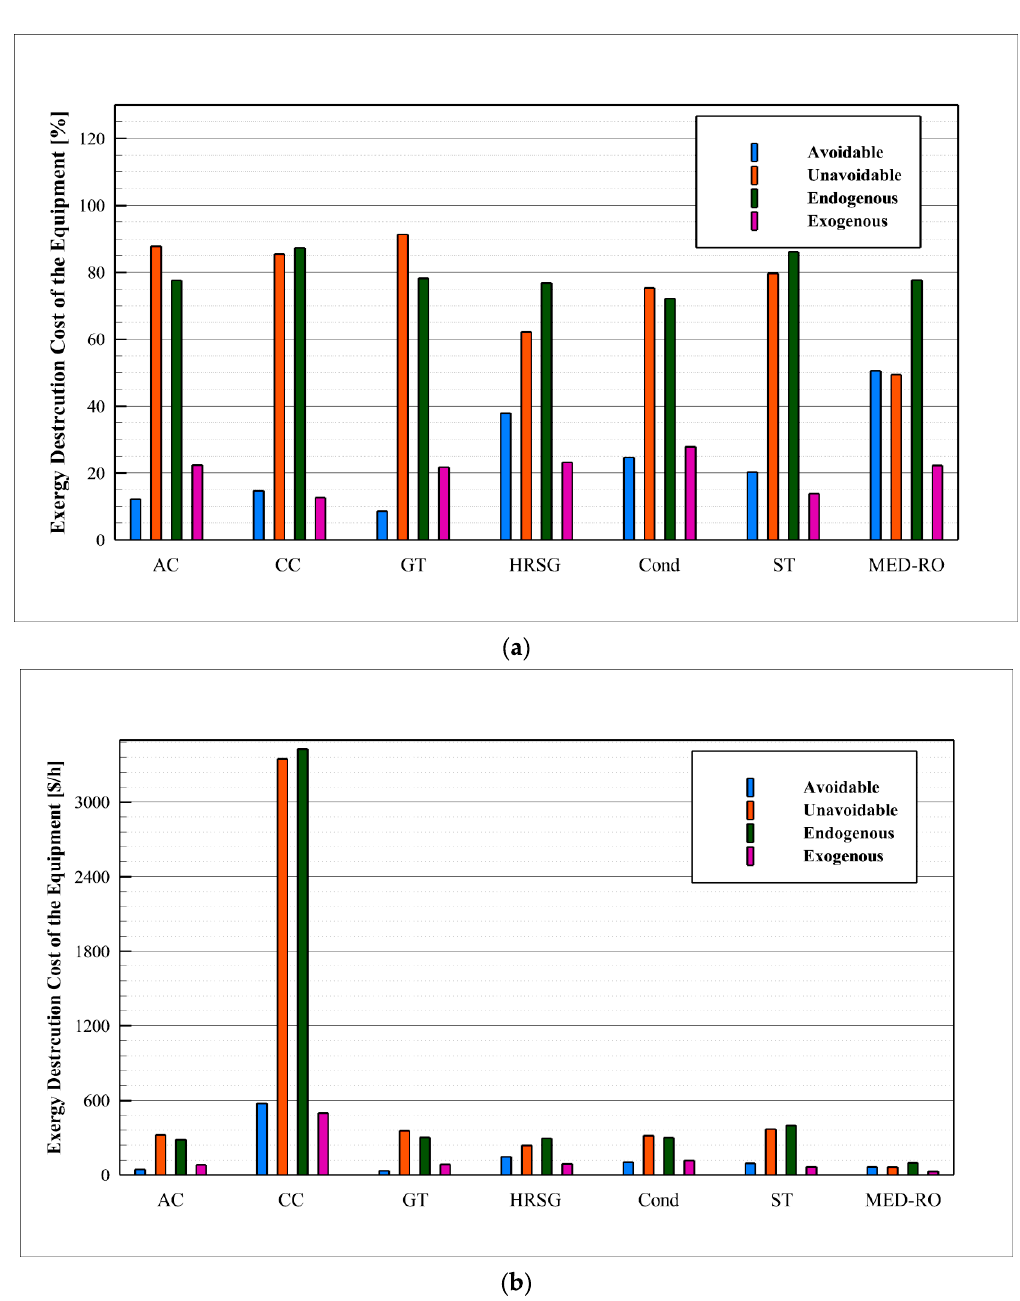
Figure 7. Distributions of avoidable/unavoidable and endogenous/exogenous exergy destruction cost for different system components in ( a ) relative values and ( b ) quantitative values. AC, air compressor; CC, combustion chamber; GT, gas turbine; HRSG, heat recovery steam generator; Cond, condenser; ST, steam turbine; MED-RO, multi-effect distillation and reverse osmosis